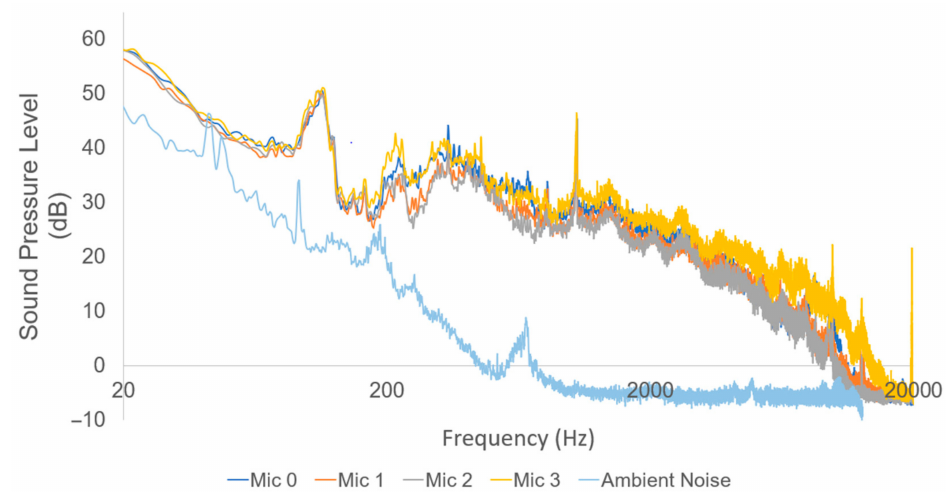
Figure 12. Acoustic measurements from all microphones during full flight